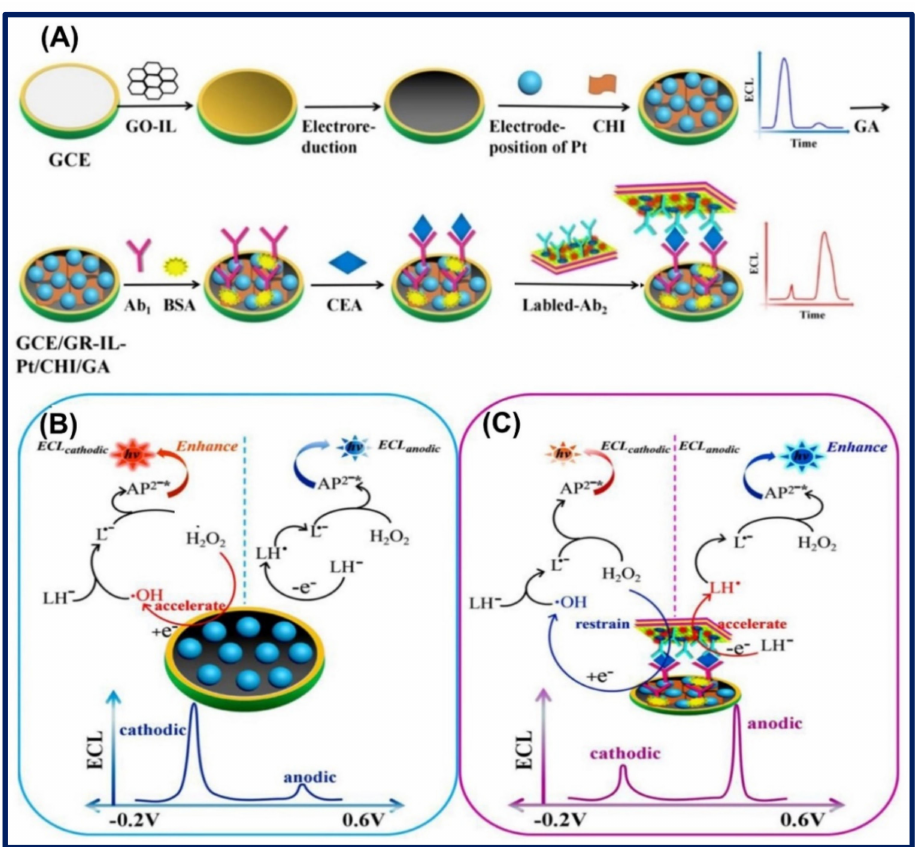
Figure 12. ( A ) The fabrication strategy of ratiometric ECL biosensor. The possible ECL mechanisms of the biosensor without ( B ) and with ( C ) Ti 3 C 2 MXenes-AuNPs-Ab2 nanoprobe. Reprinted with permission from Ref. [115]. Copyright 2020,